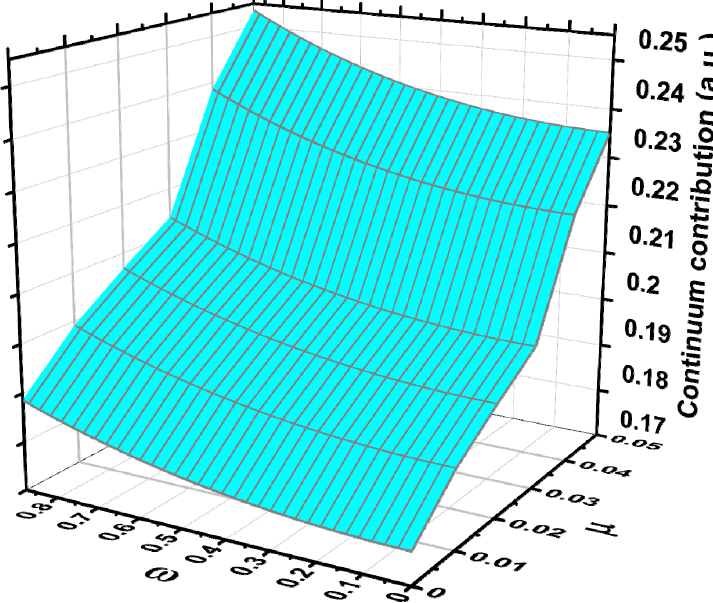
Figure 5. The contribution from the continuum states to dynamic octupole polarizability (DOP) as a function of the screening parameter and photon frequency.